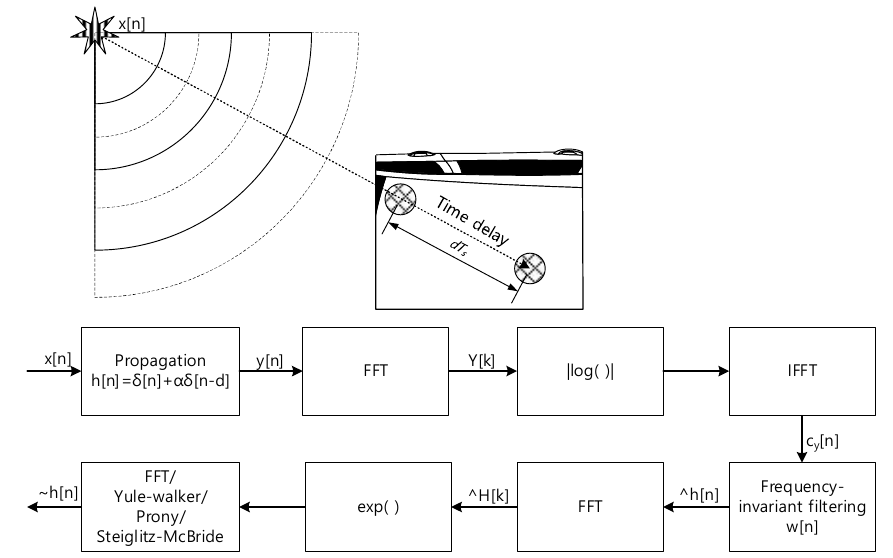
Figure 3. System architecture of time delay estimation based on the parametric and non-parametric homomorphic deconvolution.